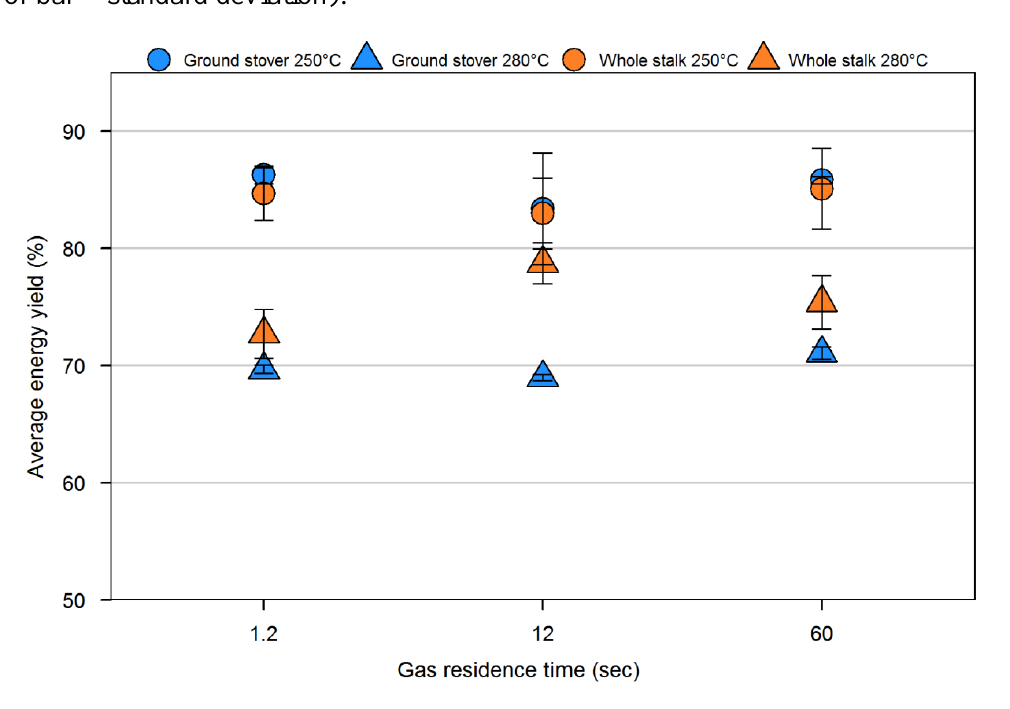
Figure 7. Average energy yield of torrefied ground stover and whole stalk samples (error bar = standard deviation).